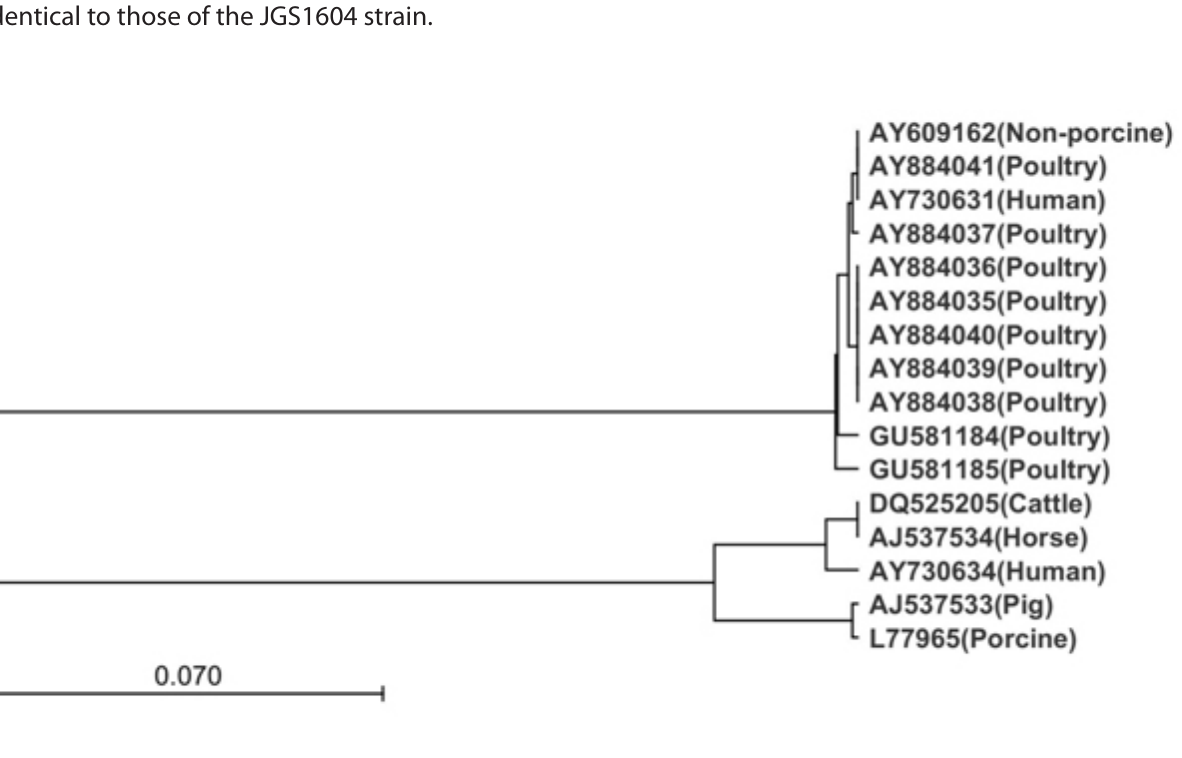
Figure 3. Phylogenetic tree of nucleotide sequence from the 532-bp cpb2 gene fragment of two Iranian C. perfringens field isolates and C. perfringens strains from various hosts published in GenBank. The tree was constructed by the Clustal method by calculating bootstrap values for 1000 replicates. Branched distances correspond to sequence